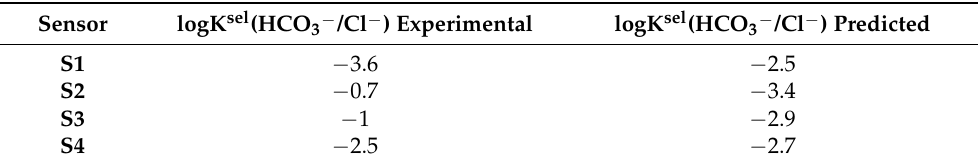
Table 3. The comparison of the predicted and the experimental logK sel (HCO 3 − /Cl − ) values ( ± 0.1 logK for experimental data) for four newly synthesized ionophores.